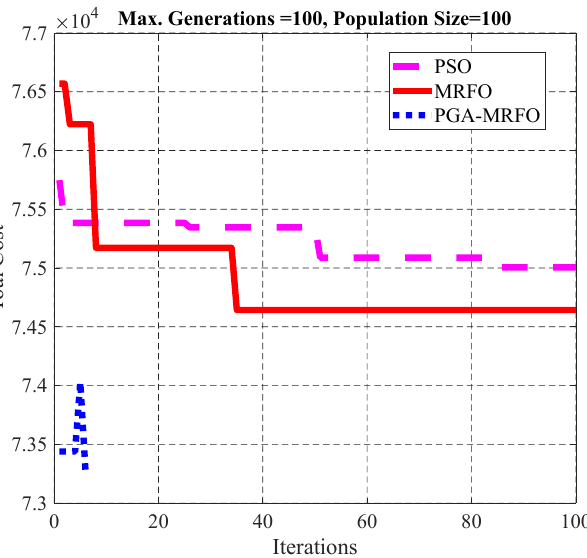
Figure 14. Converges curves for UC problem—Case 1 at max. Generations = 100.